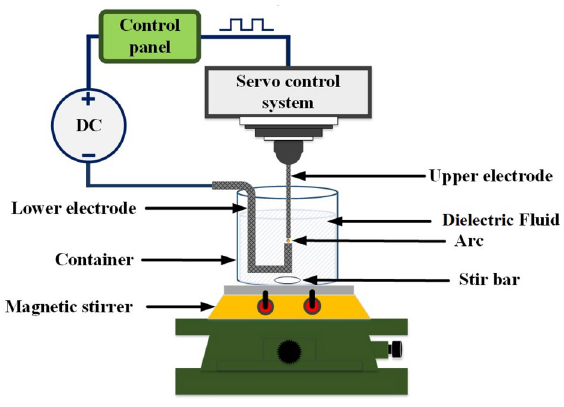
Figure 1. Schematic of an